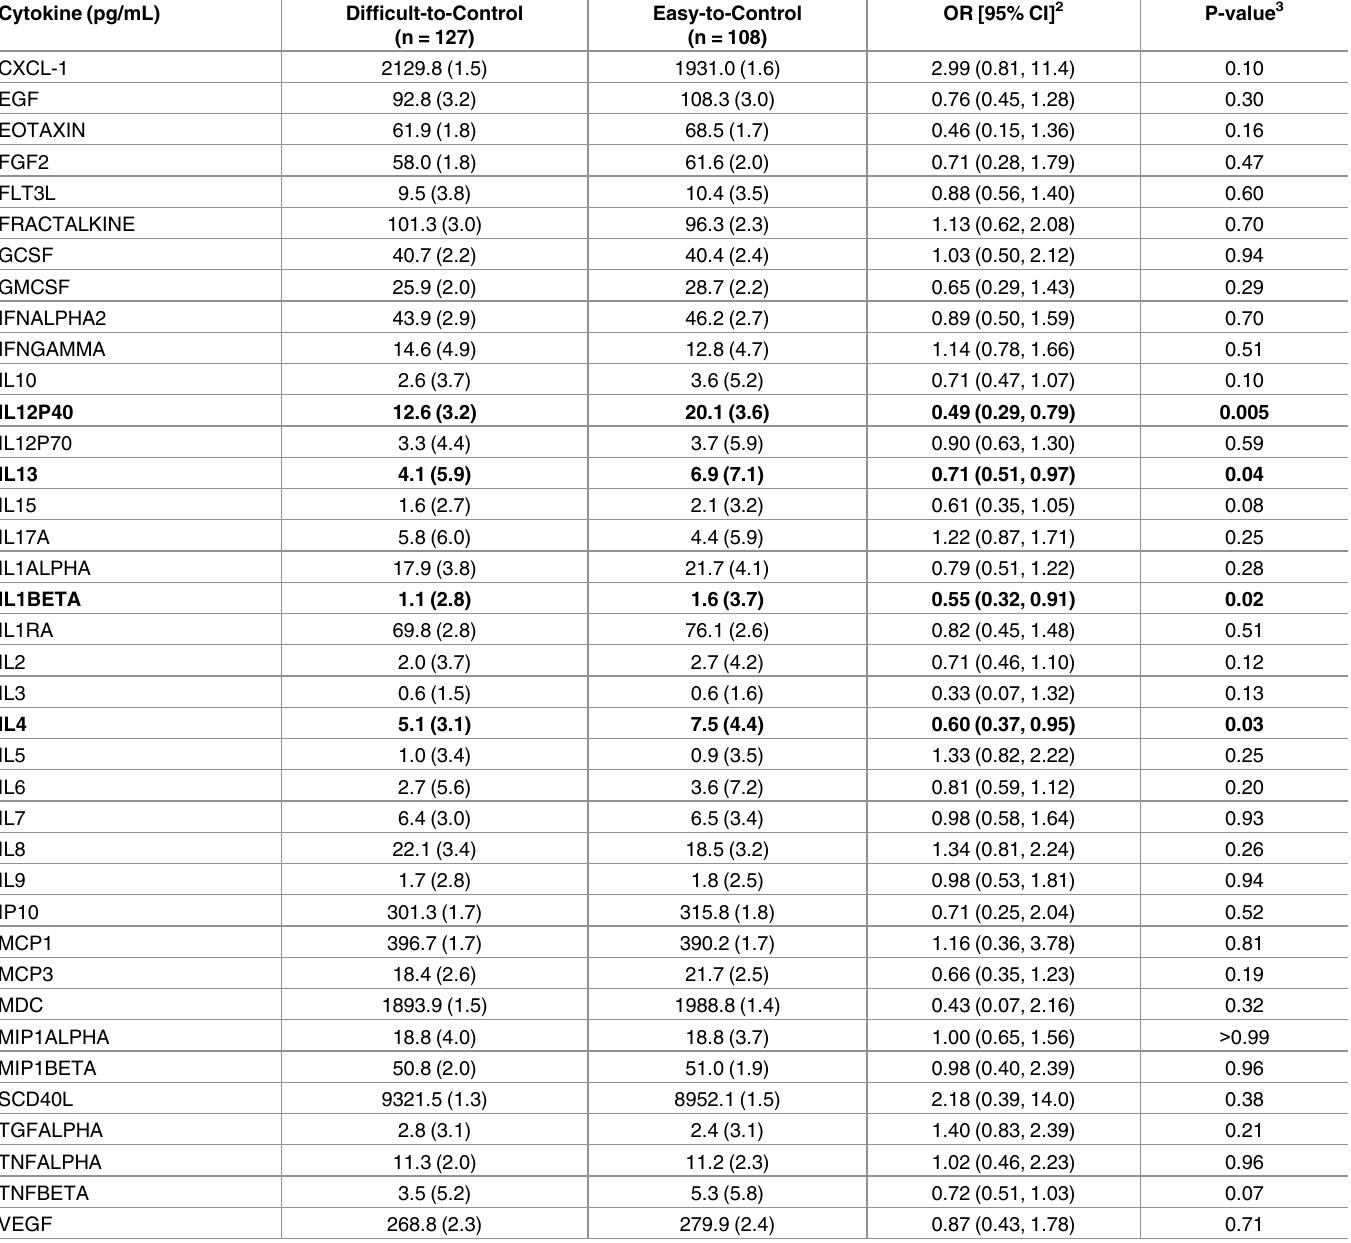
Table 3. Serum concentrations of 38 cytokines by treatment classification 1